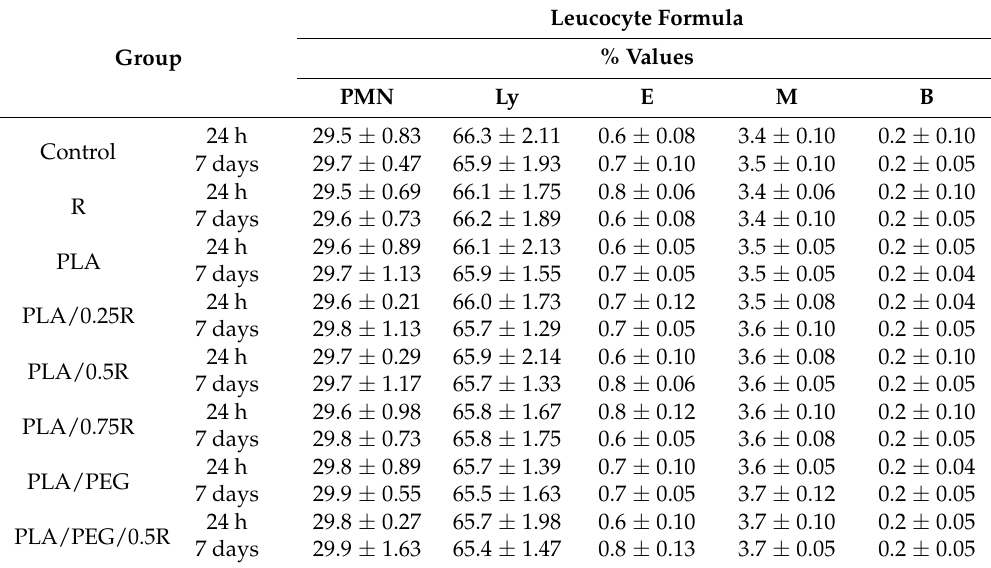
Table 12. The effects of the PLA-based materials containing rosemary ethanolic extract on the differential white cell count. Values were expressed as mean ± S.D. for six rats in a